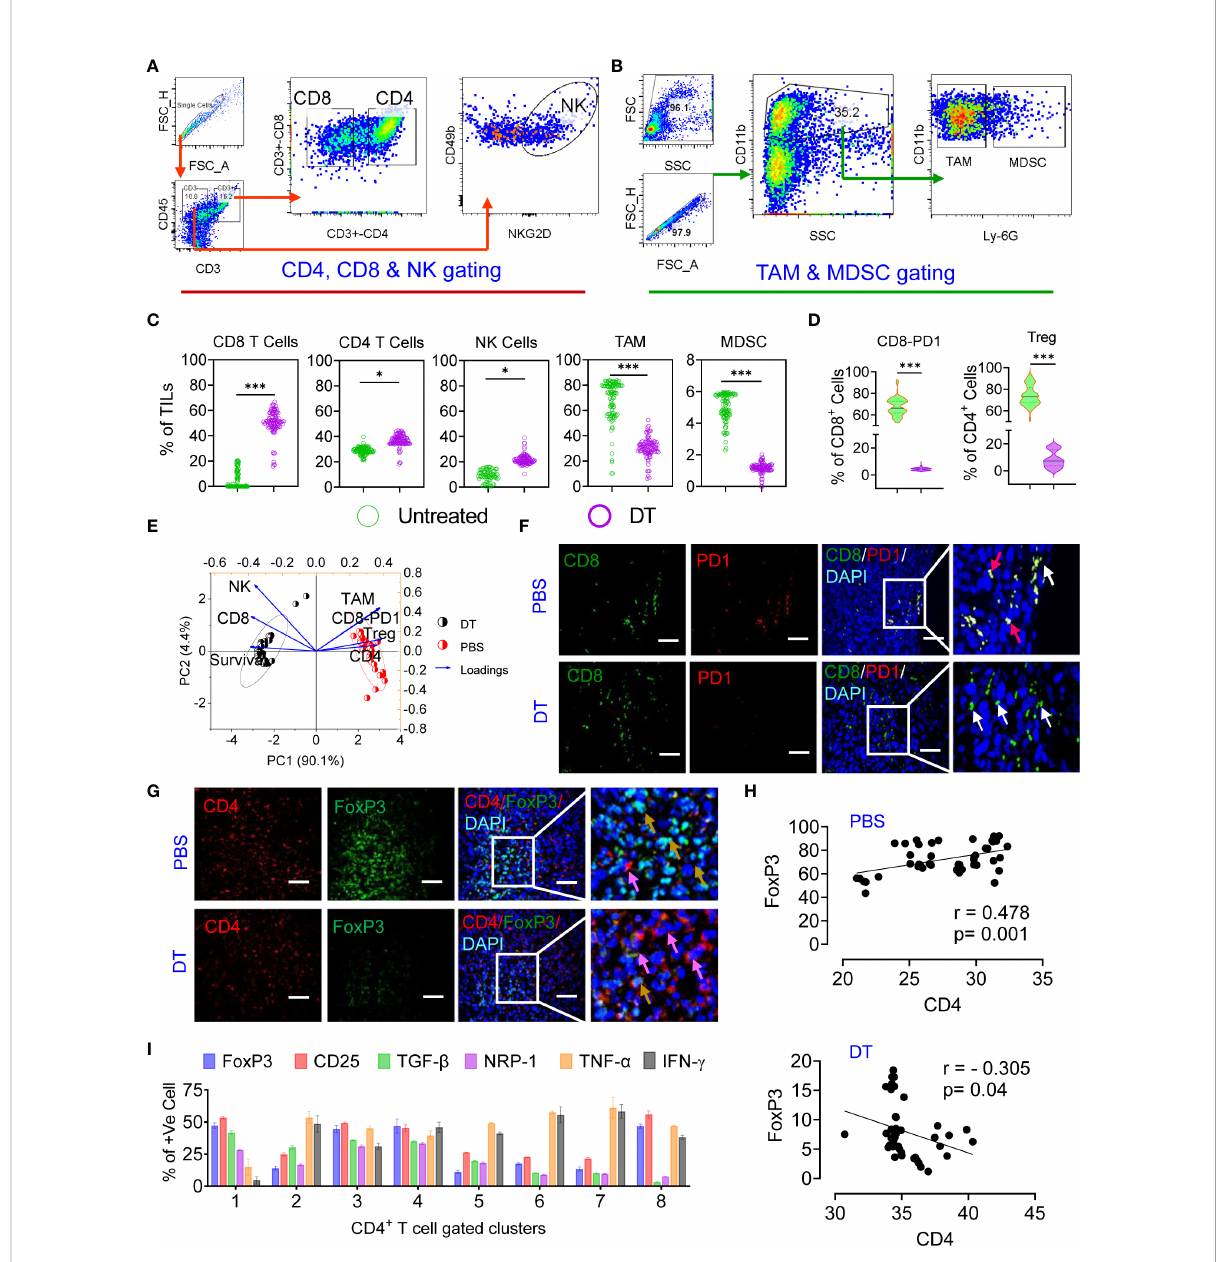
FIGURE 6 Chemoimmunotherapy prevents CD8 T-cell exhaustion and converts Treg cells to CD4 T effector cells. Gating strategy of CD4, CD8, NK cells (A) and TAMs and MDSCs (B) in TILs. The percentages of CD8 + T cells, CD4 + T cells, NK cells, TAMs and MDSCs in the percentage of TILs among the identi fi ed clusters are presented in Figure S7 (C) . Percentage of PD1 + and Foxp3 + cells among the CD8 + and CD4 + populations in the treated vs . DT groups (D) . Principal component analysis to predict the different immune cell populations in TILs correlated with median survival among treatment groups (E) . Immuno fl uorescence localization of CD8 + (green, white arrow) or CD8 + /PD1 + T cells (yellow, red arrow) (F) and CD4 + (red, pink arrow) or CD4 + /Foxp3 + dual-positive Treg cells (yellow arrow) in the tumor tissue of the untreated and dual-treated groups, scale bar 10 µM (G) . A representative image of 3 similar experiments is shown. Linear regression and correlation analysis of CD4 vs . Foxp3 cells among the untreated (r=0.478, p=0.001) and dual-treated (r= -0.305, p=0.04) groups (H) . The percentages of Foxp3, CD25, TGF- b , NRP-1, TNF- a and IFN- g among the identi fi ed clusters are presented in Figure S7 g (I) . All p values were calculated using one-way ANOVA and corrected for multiple comparisons using Tukey ’ s adjustment. Unless otherwise noted, the data are presented as independent biological triplicates. *p < 0.05, and ***p <